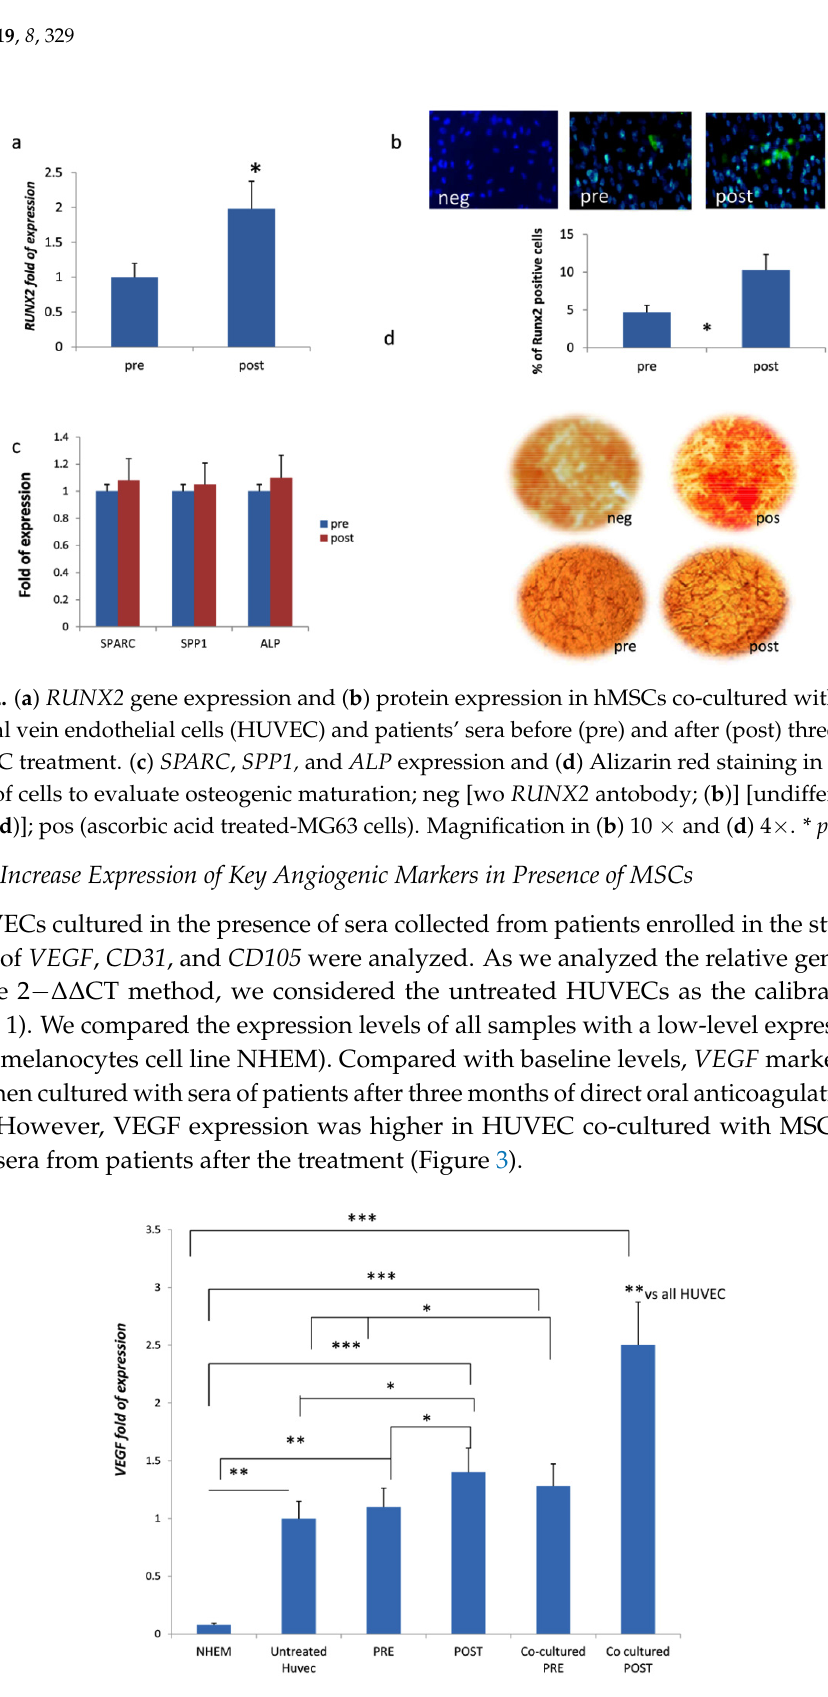
Figure 3. VEGF expressed in HUVEC treated with patients’ sera collected before (PRE) and after (POST) three months of DOAC treatment. The sera (PRE or POST treatment) were added in HUVEC co-cultured with hMSCs. NHEM: normal melanocytes used as low expressing cells. * p < 0.05; ** p < 0.01; *** p < 0.005.